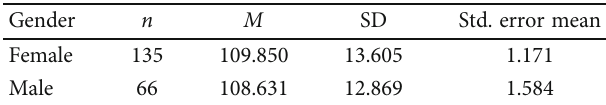
Table 1: The results of descriptive statistics of male and female